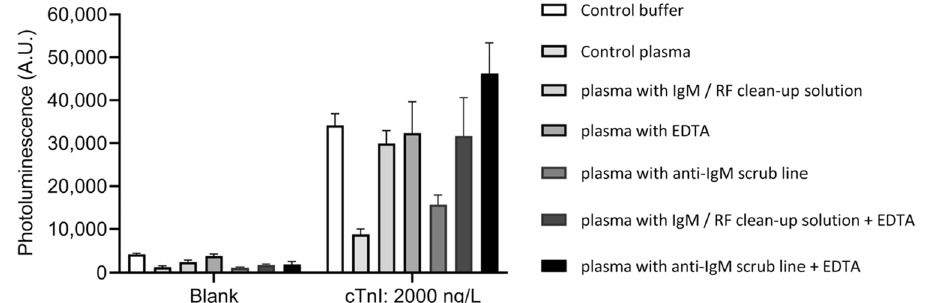
Figure 1. The effect of sample pre-treatment on plasma interference. All samples were analysed as unspiked (blank) and spiked with 2000 ng/L of cTnI before the pre-treatment. Pooled EDTA plasma samples were used in this experiment. IgM and RF commercial clean up solution was compared to 250 mM EDTA, IgM scrub line (prior to test line) and to different combinations. The error bars represent standard deviations of three replicate LFIA